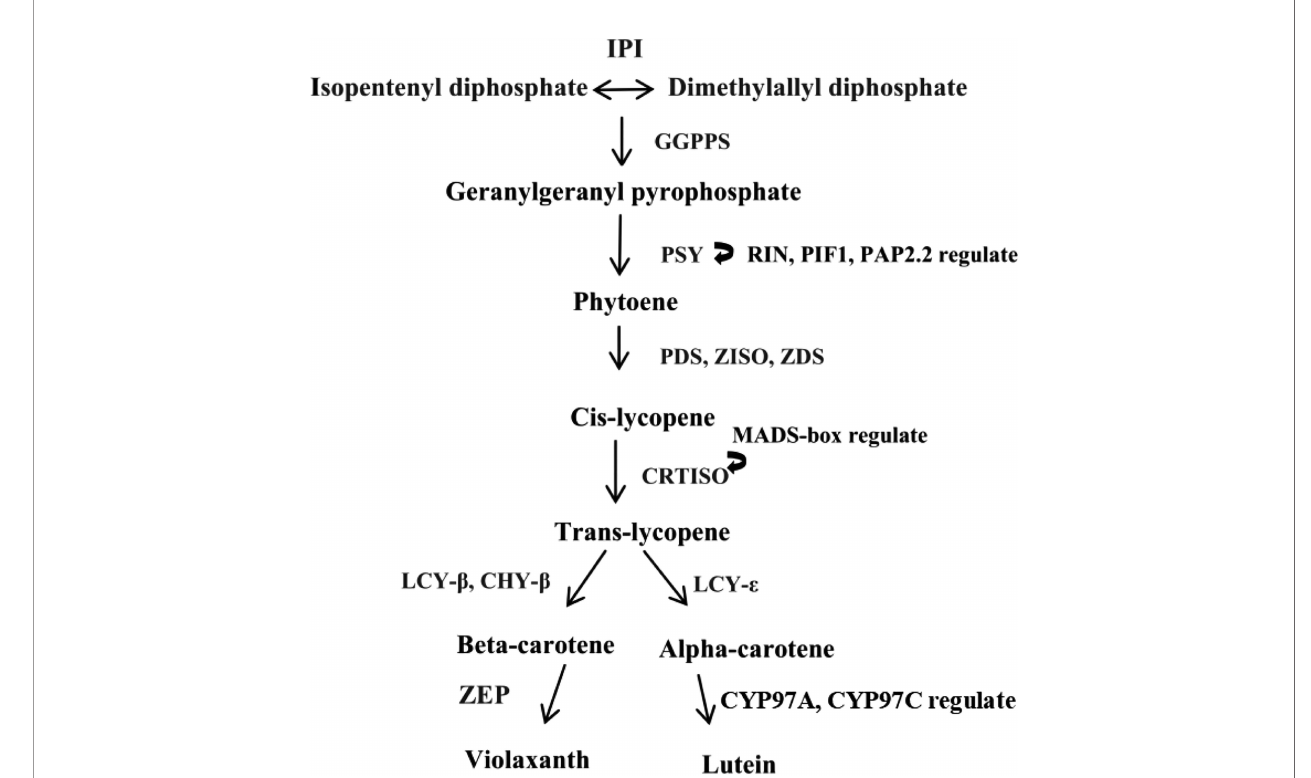
FIGURE 1 | A graphic representation depicting the putative carotenoid biosynthetic pathway in microalgae. IPI, isopentenyl diphosphate isomerase; GGPPS, geranylgeranyl diphosphate synthase; PSY, phytoene synthase; PDS, phytoene desaturase; ZDS, zeta-carotene desaturase; CRTISO, carotenoid isomerase; ZISO, z -carotene isomerase; LCY- b , lycopene b -cyclase; CHY- b , beta-carotene hydroxylase; LCY- ϵ , lycopene ϵ -cyclase; ZEP, zeaxanthin